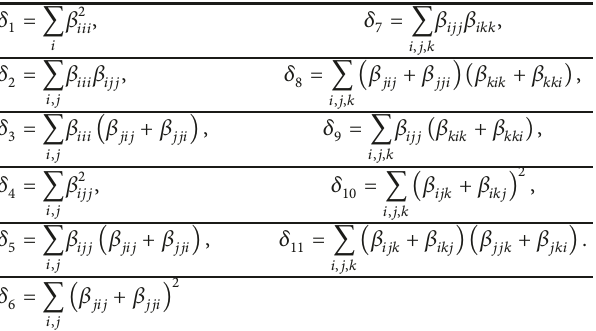
Table 1: The HRS first hyperpolarizability 𝛿 𝑛 coefficients.